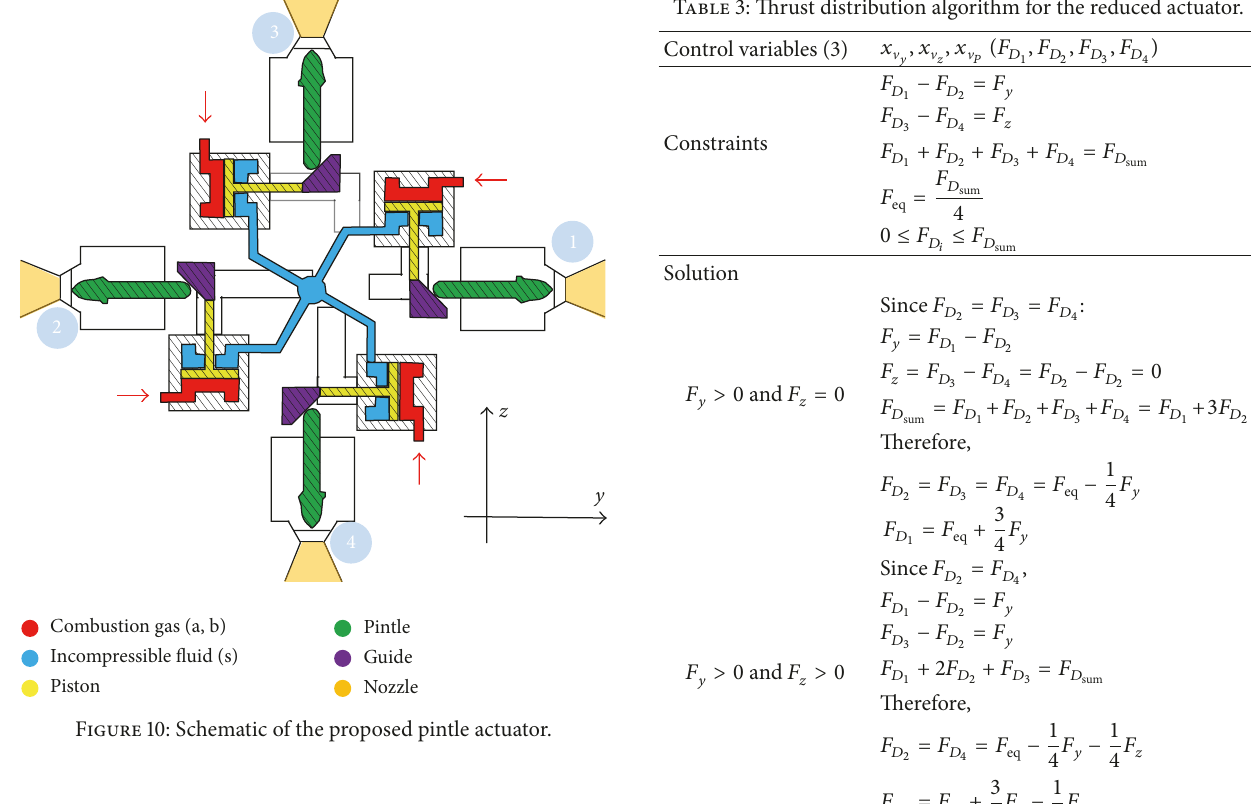
efficiency of the proposed system cannot be compared easily to the conventional system, since the maneuver is optimized with respect to the equalized state only.